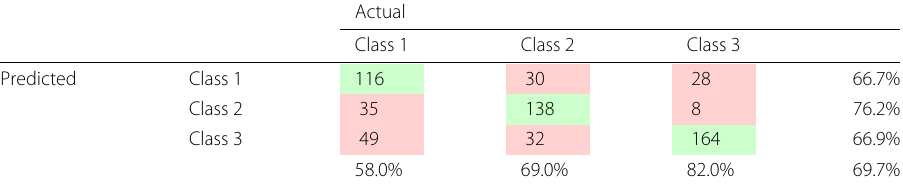
Table 8 Confusion matrix using features obtained with CWT. Total classification accuracy is 69.7%